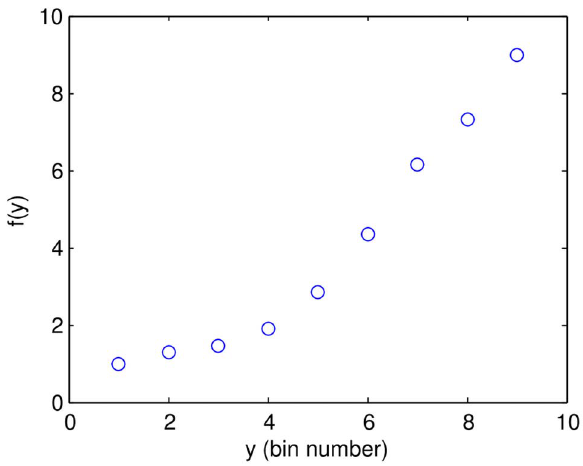
Figure 6. Generalizing the fitted function by replacing the output values y with a non-linear function f ( y ) improves the least squares fit. Constrained non-linear optimization found the ~ 0 : 514 + 0 : 002 . The non- optimal f ( y ) for the linear model with r 2 opt linearity is due to the first few bins being dominated by background fluorescence and not gene